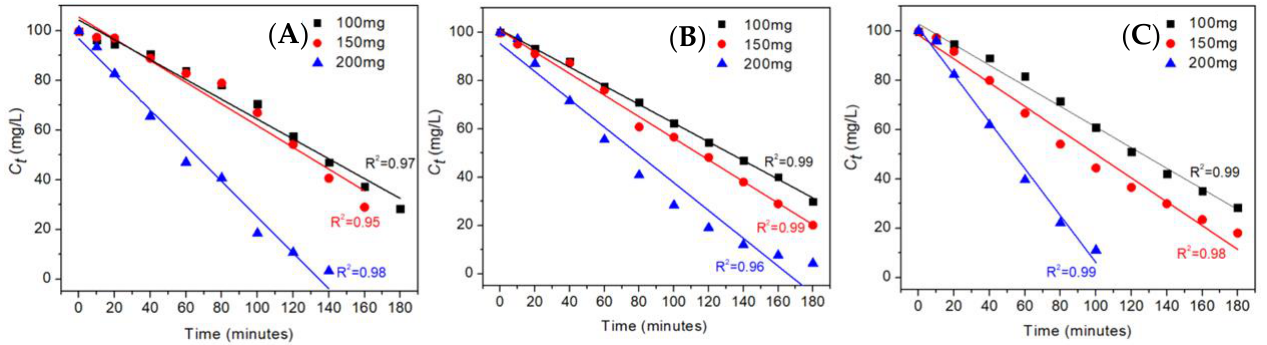
Figure 9. Kinetic plot for RB5 decolorization ( A ) Ni50-Fe50 wt%, ( B ) Ni80-Fe20 wt%, and ( C ) Ni90- Fe10 wt% samples.